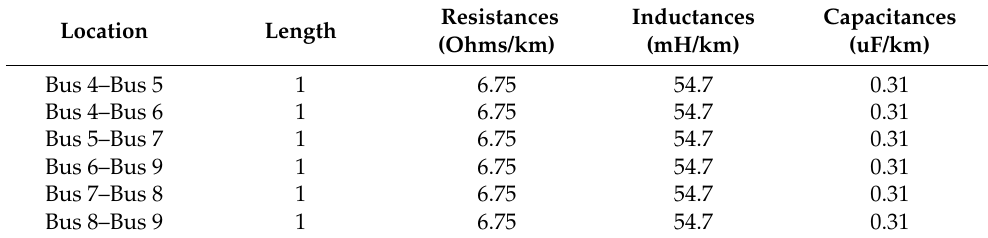
Table A5. The parameters of the transmission lines.